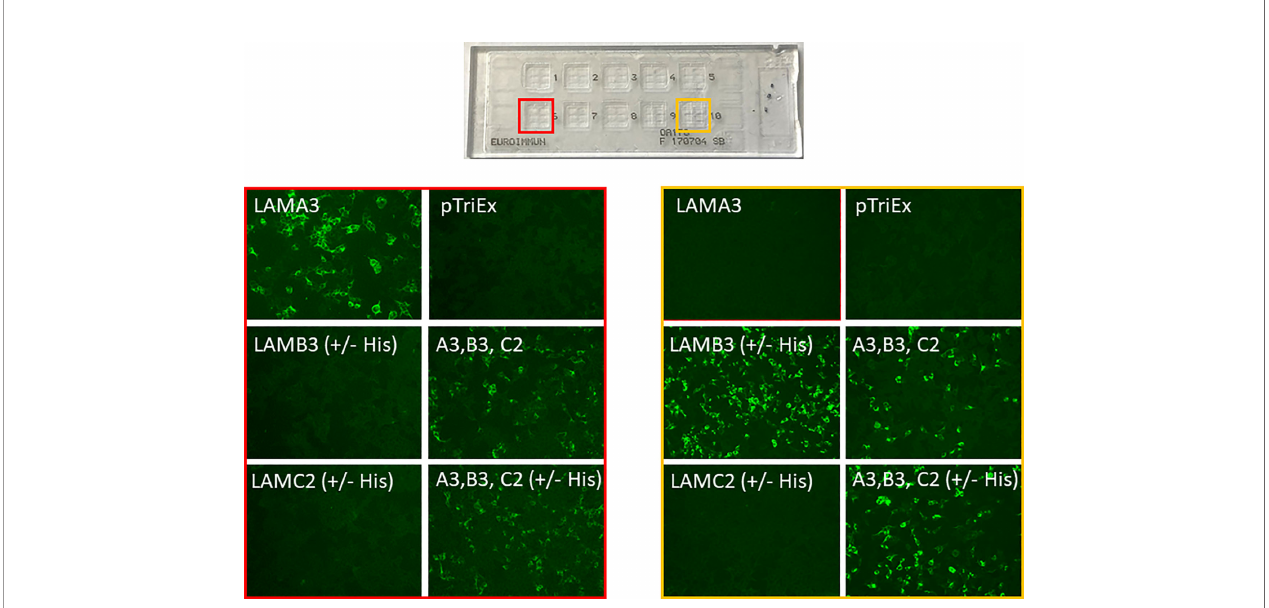
FIGURE 1 | Representative pictures of the indirect immuno fl uorescence biochip mosaic assay using membrane-bound recombinant laminin a 3 (LAMA3), b 3 (LAMB3), g 2 (LAMC2), the a 3 b 3 g 2 heterotrimer (A3, B3, C2) with and without His-tag, and empty plasmid (pTriEx) expressed in HEK293 cells. Sera from patients with anti-laminin 332 MMP with anti-laminin a 3 reactivity (red box) and anti-laminin b 3 reactivity (yellow